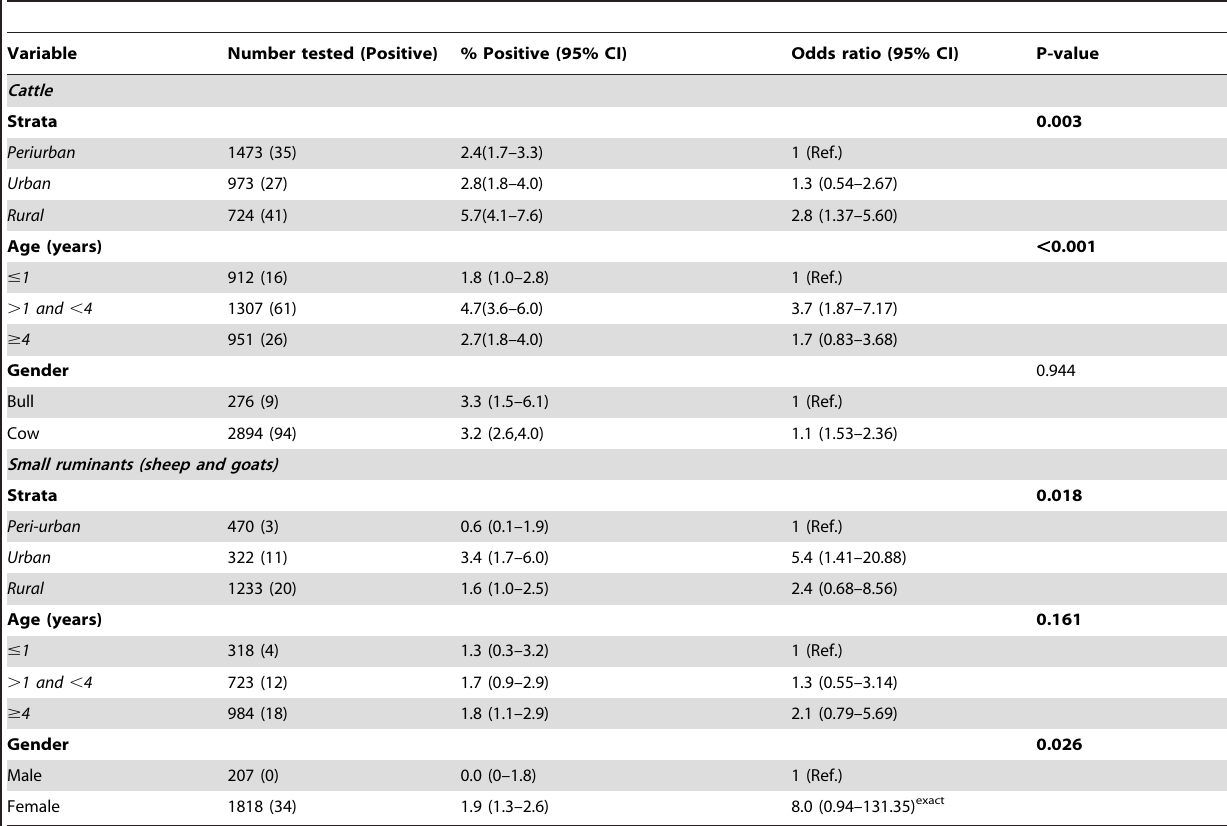
Table 4. Potential risk/indicator factors associated with individual animal-level brucellosis seropositivity among 5195 animals nested within 681